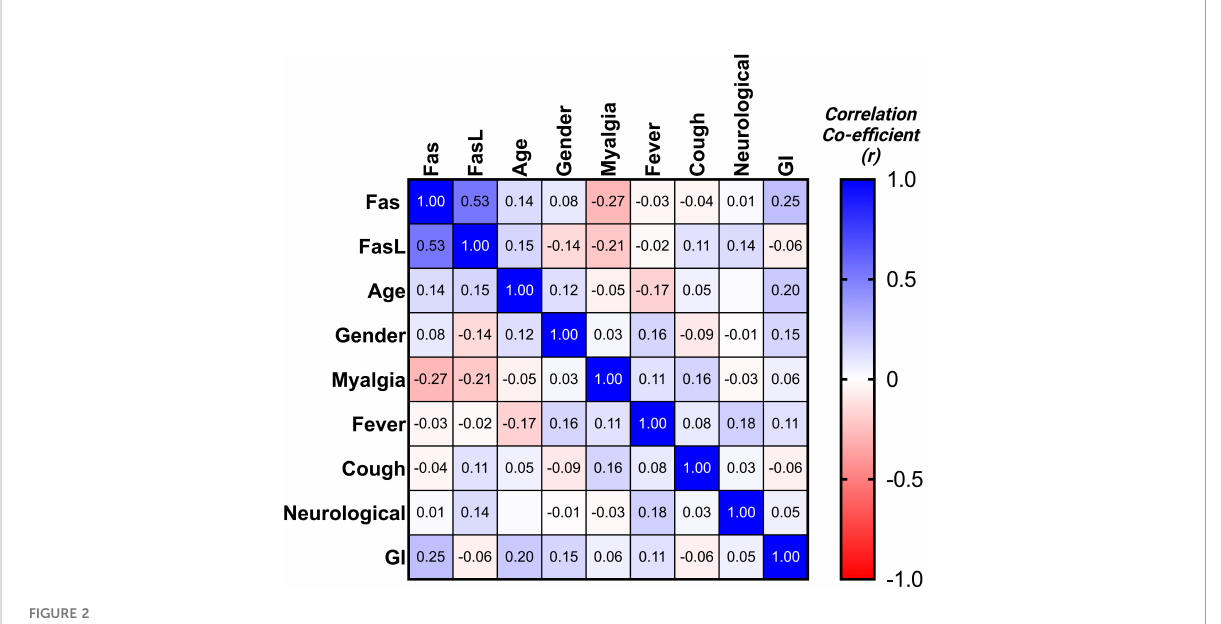
FIGURE 2 Correlation matrix for Fas/FasL and clinical disease